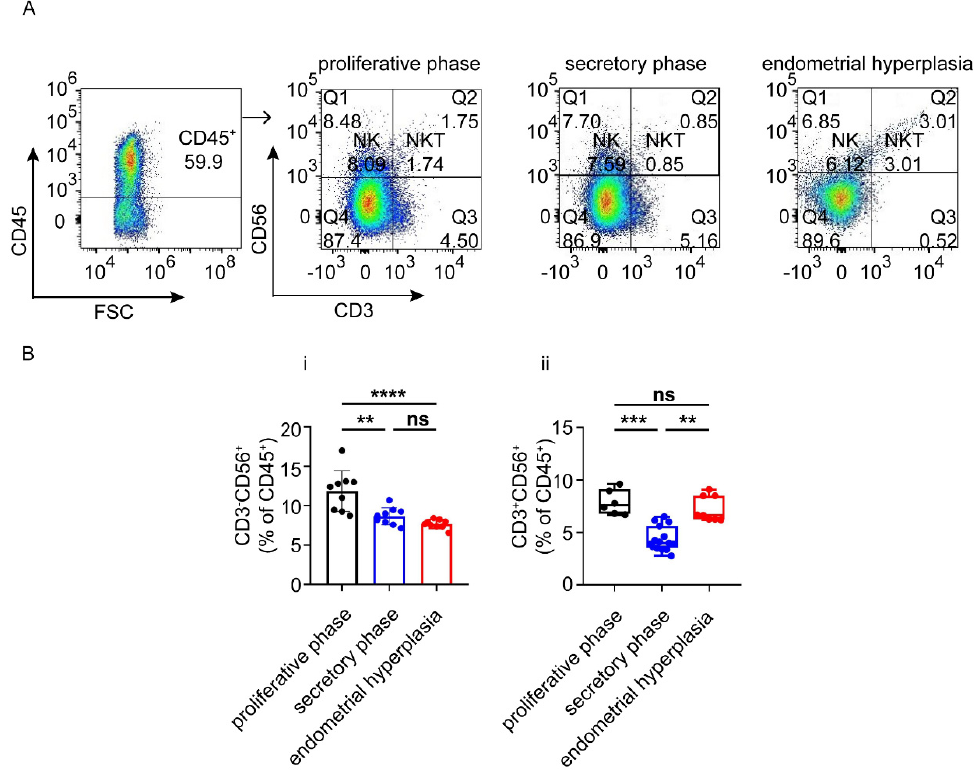
Figure 4. NK and NKT cells in proliferative phase, secretory phase and endometrial hyperplasia endometrium of AUB patients. ( A ) CD45 + gate, followed by CD3 +/ − CD56 + gate, was used to distinguish NK cells and NKT cells. ( B ) Graph shows the proportions of general NK cells and NKT cells in three groups. Data are presented as the mean ± standard error of the mean ( B.i ), or the median and the interquartile range ( B.ii ). Statistical significance (one-way ANOVA with a Bonferroni multiple-comparisons test ( B.i ) or Kruskal–Wallis test with Dunn’s multiple-comparisons test ( B.ii )): ** p < 0.01, *** p < 0.001, **** p < 0.0001, ns, no significant difference.